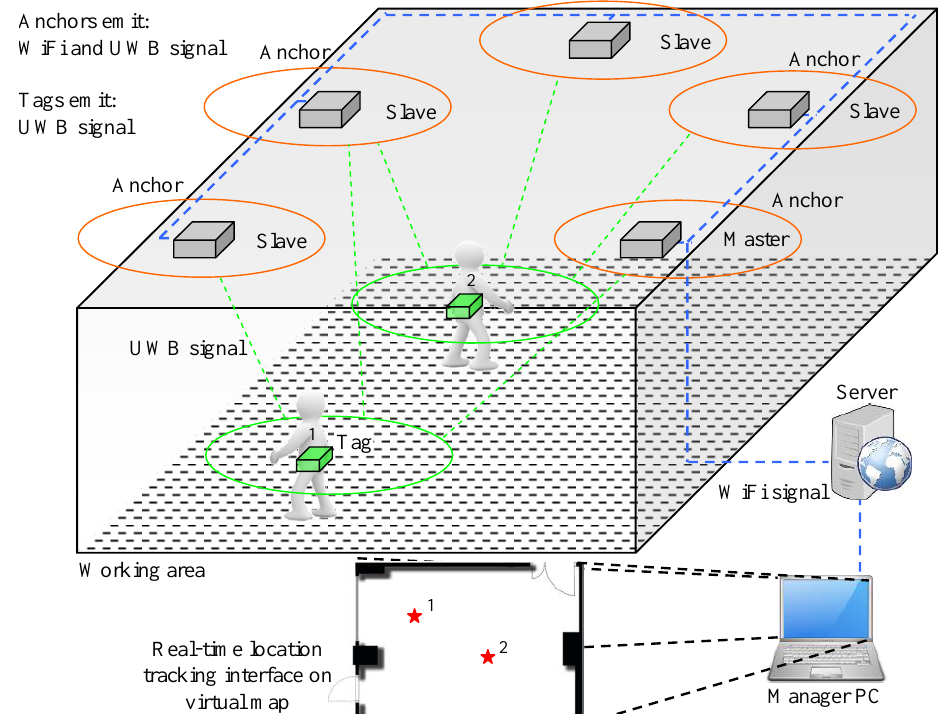
Figure 1. Architecture of real-time location